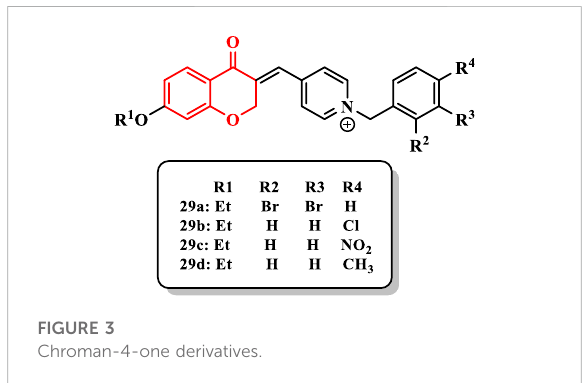
FIGURE 3 Chroman-4-one